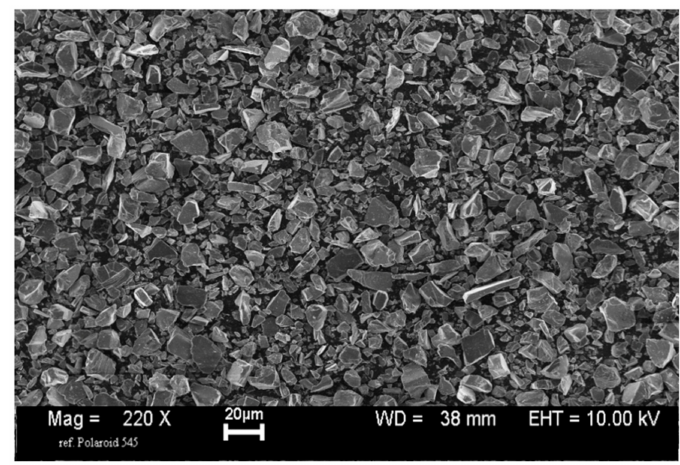
Figure 6. SEM of SiC powder [34].